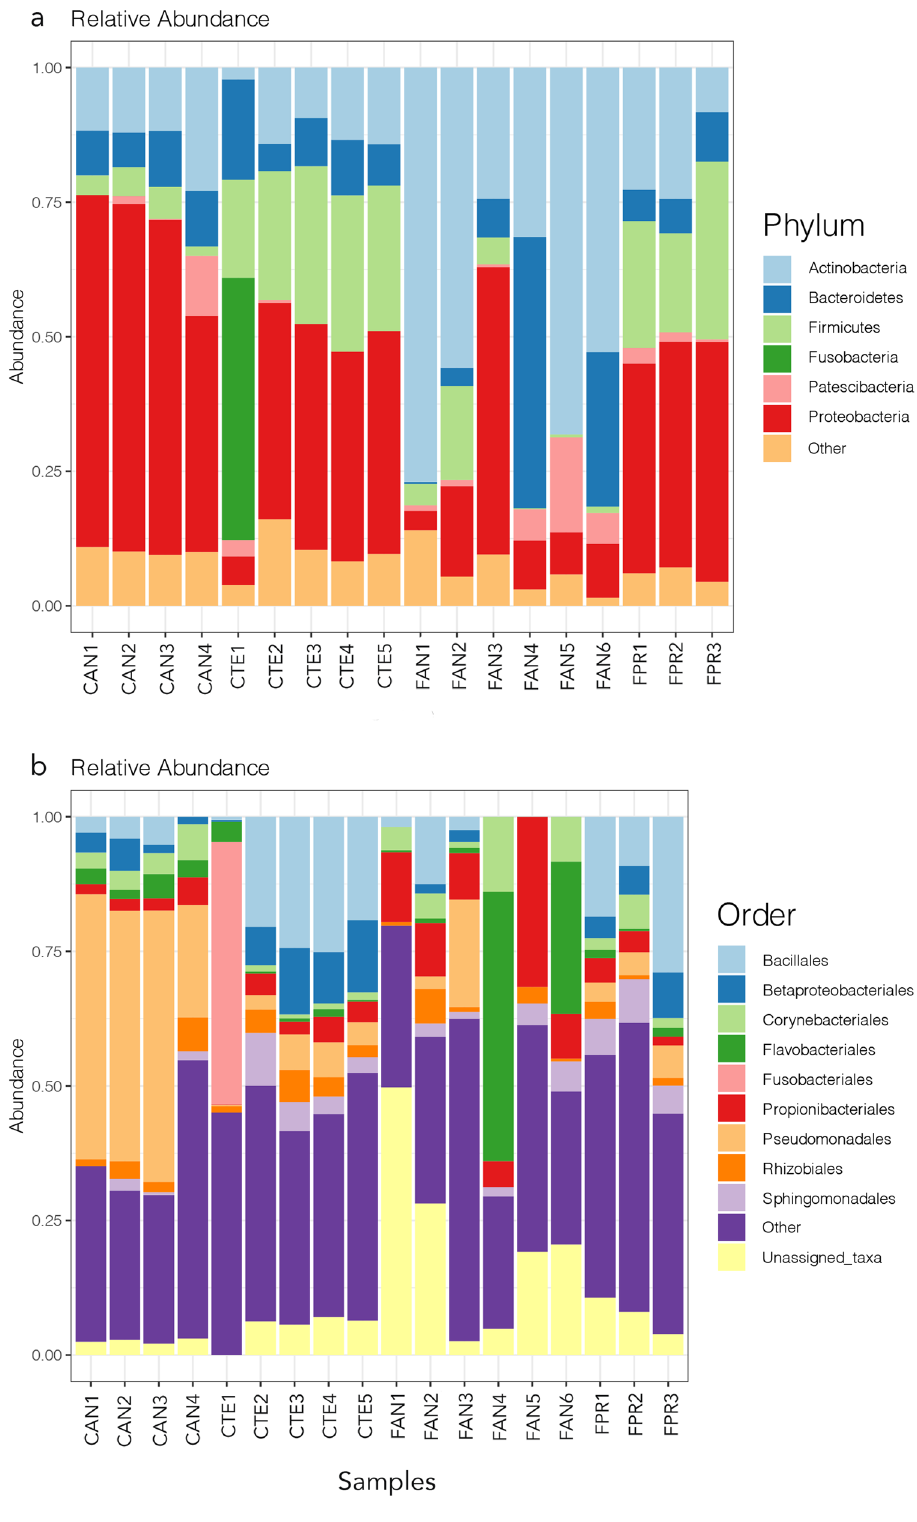
Figure 1. Relative abundance plots of the most frequent bacterial OTUs at the phylum ( a ) and order ( b ) levels. Samples are grouped according to host species and sampling location, see Table 1 for explanation of codes. The figure was generated using the R package ggplot2 v3.2.1 (https ://ggplo t2.tidyv